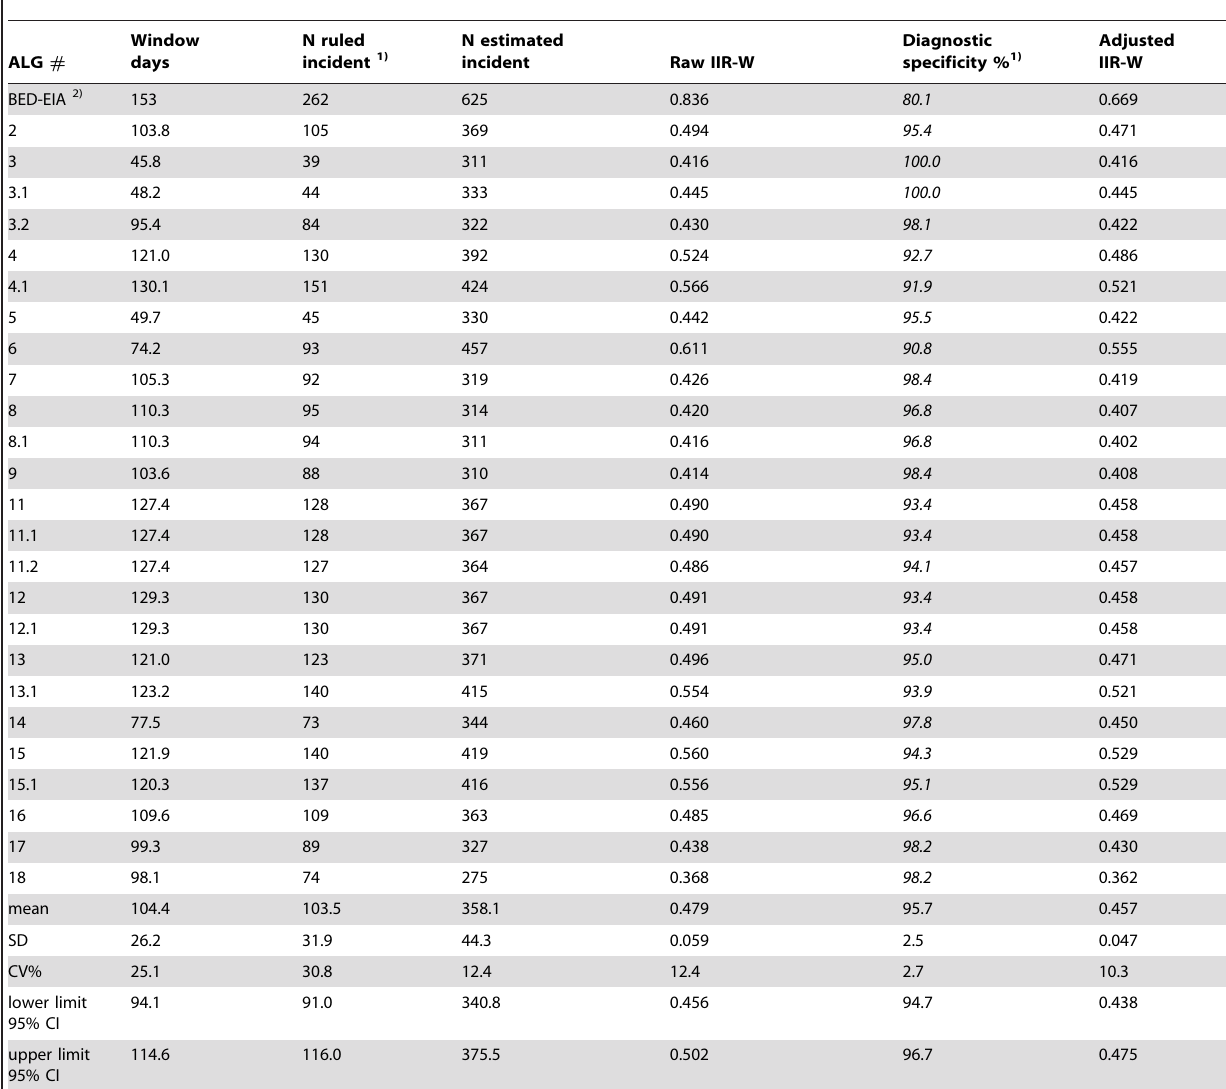
Table 3. Window-based incident infection rates (IIR) among the 748 HIV notifications July 05–June 06.